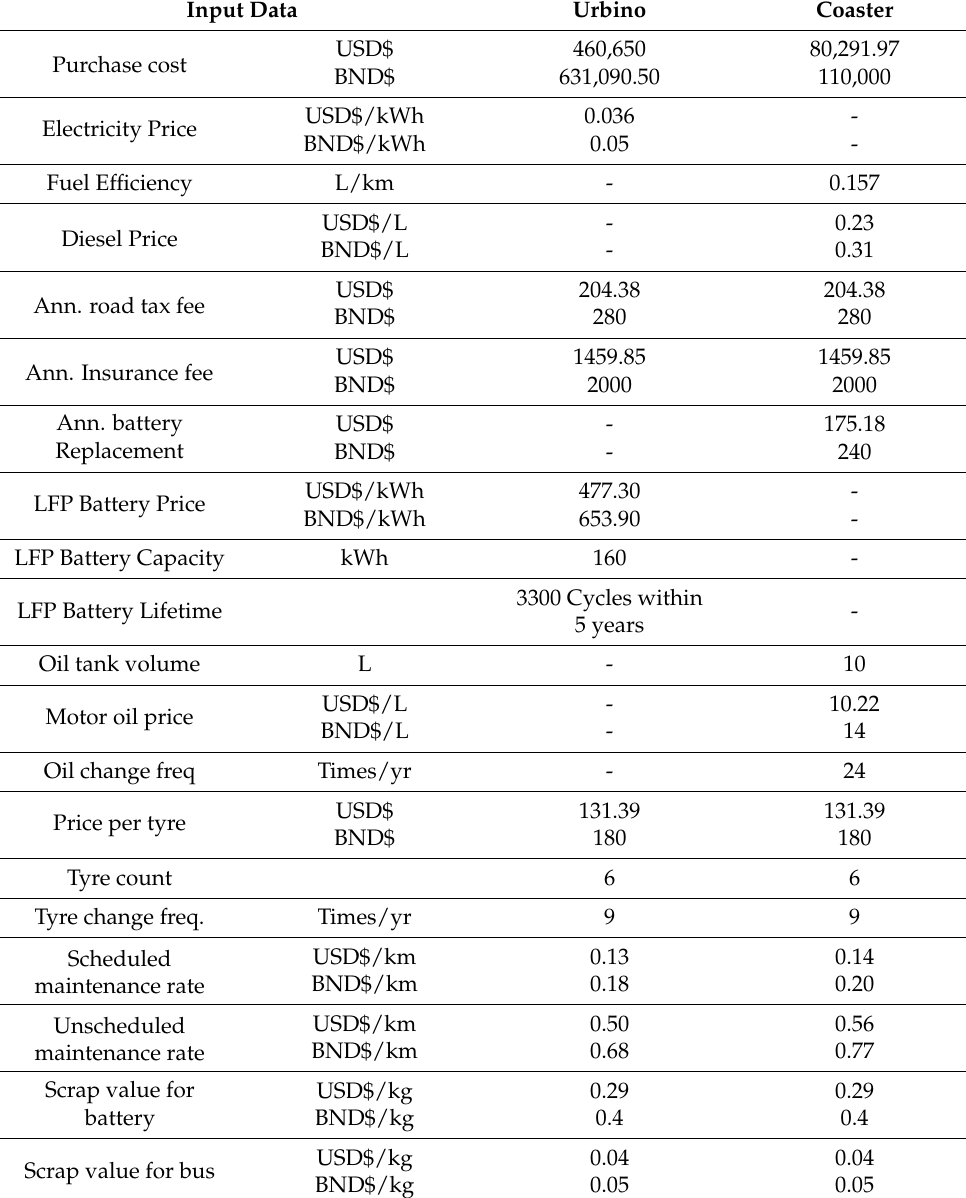
Table 3. Important parameters used for the calculations